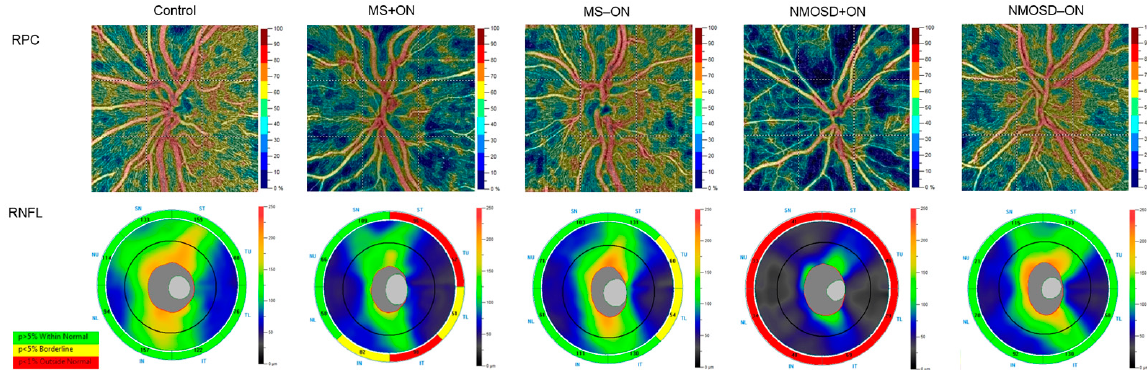
Figure 1. Representative OCT angiography and spectral-domain OCT images of the healthy, MS+ON, MS − ON, NMOSD+ON, and NMOSD − ON left eyes. The color-coded flow density maps present reduced retinal peripapillary vessel density in eyes with a history of optic neuritis, more pronounced in the NMOSD+ON eye. The attenuation of large retinal vessels is only seen in the NMOSD+ON eye. The corresponding RNFL thickness maps show an axonal loss on the temporal side of the optic disc in the MS+ON and MS − ON eyes, whereas, in the NMOSD+ON eye, all sectors were markedly thinner. MS = multiple sclerosis; NMOSD = neuromyelitis optica spectrum disorder; OCT = optical coherence tomography; ON = optic neuritis; RNFL = retinal nerve fiber layer; RPC = radial peripapillary